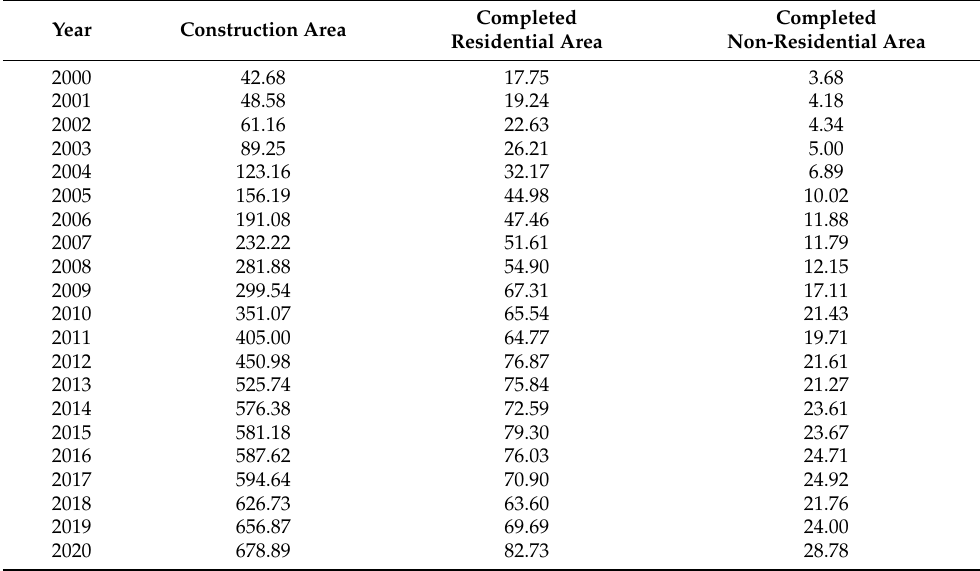
Table 2. Details of the floor area of Jiangsu Province 2000–2020. (unit: million m 2